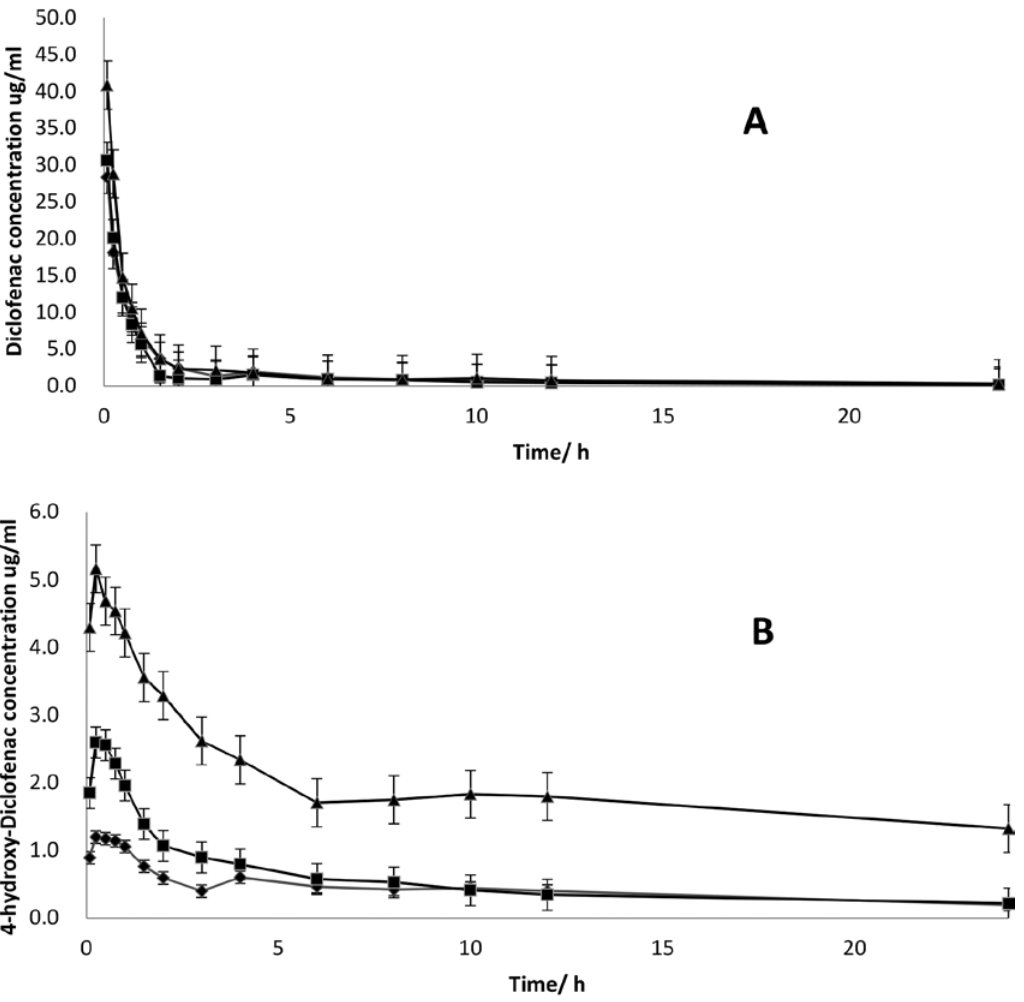
FIGURE 3 - Mean plasma concentration-time profile of diclofenac and 4´-hydroxy diclofenac with iguratimod in rats. The concentration of diclofenac (A) and 4-hydroxy diclofenac (B) in plasma were plotted against the time after administration of 15 mg/kg diclofenac and IGU at normal saline (  ), low IGU 10 mg/kg (  ) and high IGU 30 mg/kg (  ). Each value represents the mean±S.D. of eight animals each. (A) Diclofenac (B)